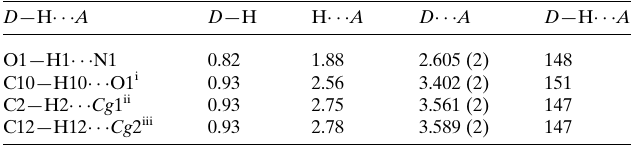
Table 1 Hydrogen-bond geometry (A˚ , (cid:4) ). Cg 1 and Cg are the centroids of the C1–C6 and C9–C14 rings, respectively.